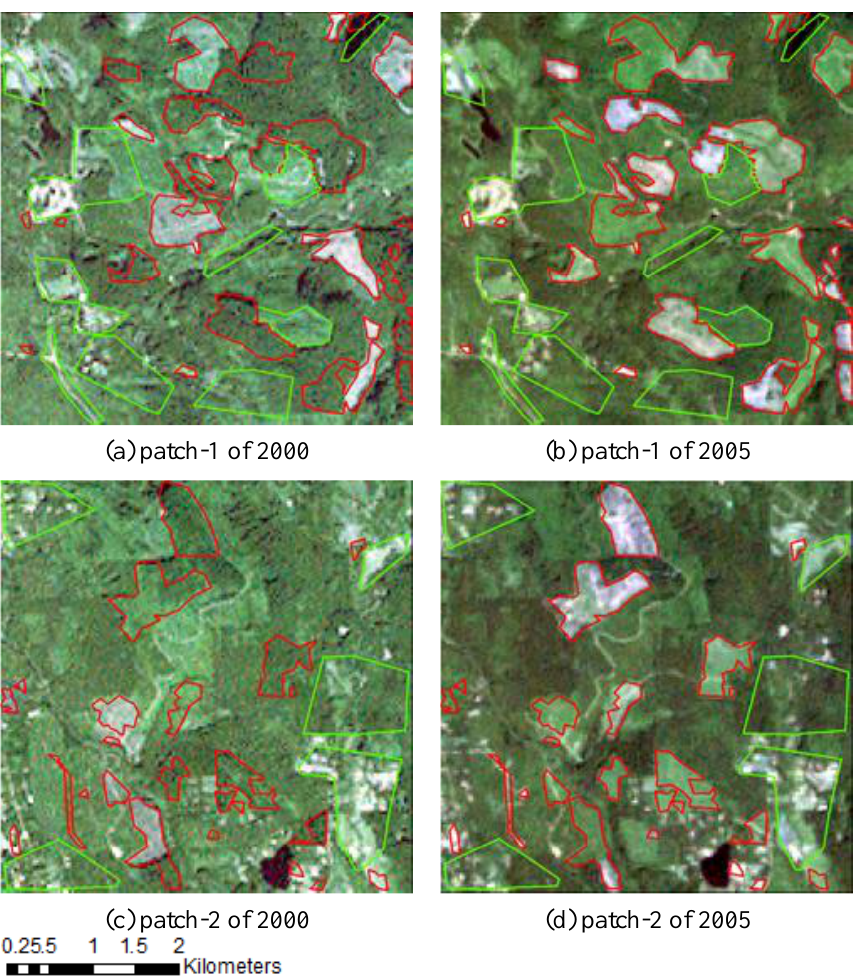
Figure 6. The large version of patches in Figure 5. The reference information of changed areas and unchanged areas were delineated by red polygons and green polygons respectively.